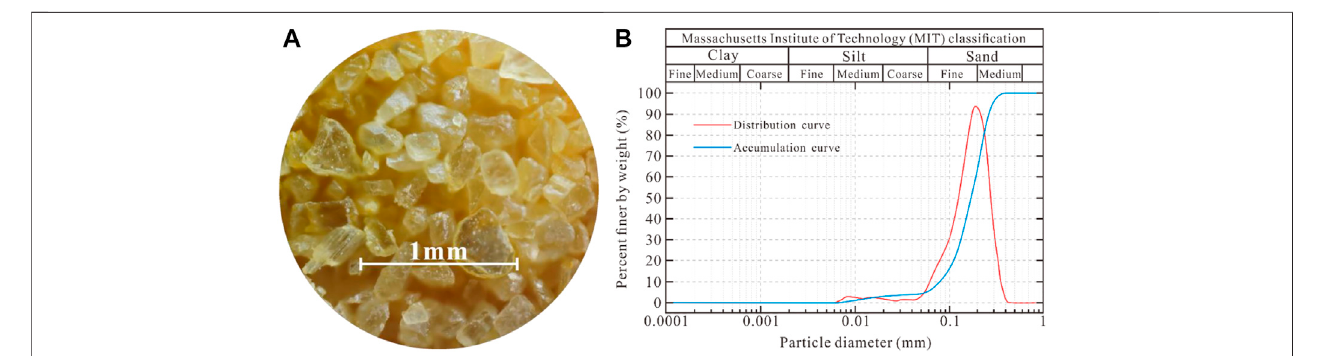
FIGURE 2 | (A) Experimental material and (B) particle-size distribution and accumulation curves.